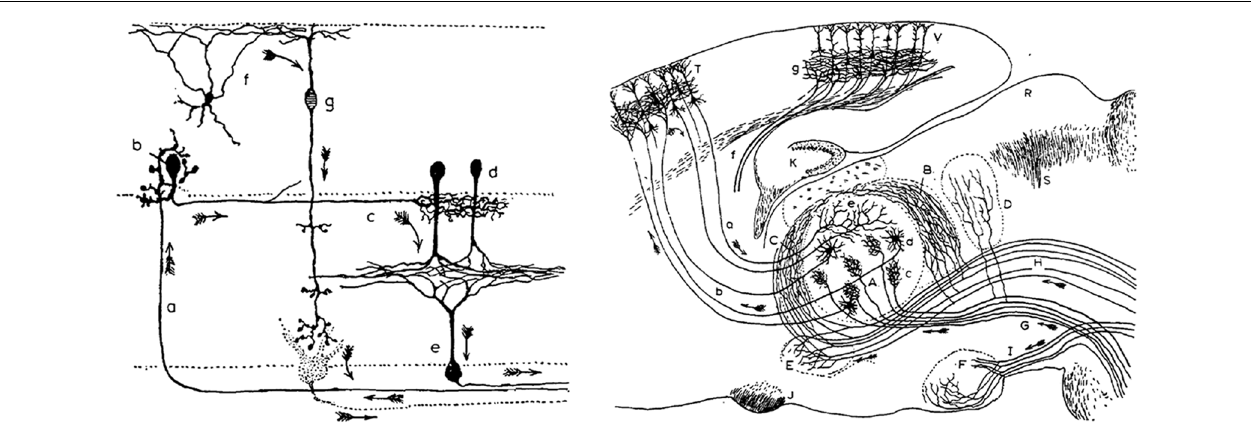
FIGURE 1 | Early descriptions of feedback pathways in subcortical and cortical structures. These drawings of neural circuits by Santiago Ramón y Cajal are among the first depictions of feedback pathways. (Left) Ramón y Cajal’s drawing of retinal circuitry. Arrows in the downward direction (arrows “g” and “e”) reflect feedforward or centripetal pathways from the photoreceptors towards higher-order brain structures for the transmission of visual stimuli. Ramón y Cajal additionally noted the presence of feedback or centrifugal fibers (arrow “a”) which originate in higher-order brain areas and target the retina. Thus, feedback occurs even at the earliest levels of sensory processing. (Right) Ramón y Cajal’s drawing of pathways of the somatosensory system. Demarcated are feedforward fibers from the brainstem to thalamus (arrow “G”) and from the thalamus to the cortex (arrow “b”). Also illustrated here are feedback fibers from cortex to thalamus (arrow “a”). While feedback fibers appear to be relatively sparse near the periphery, they are highly abundant in the thalamocortical system. In describing this anatomical organization during his Nobel prize speech in 1906, Ramón y Cajal speculated as to the function of feedback: “What is the role of the centrifugal fibres? Are they, as Duval thinks, conductors destined to produce in the sensory pathway articulations a very intimate contact which would be indispensable for the satisfactory propagation of the nervous impulse? Or rather do they transport some form of energy from the brain, the rapid accumulation of which in the sensory stations is necessary for the passage of ascending nerve currents? Unfortunately, at this stage of science, it is impossible to give satisfactory and categorical answers to these questions”. Now, over 100 years later, scientists continue to debate the functions of feedback fibers (panels and quote are reproduced with permission from © The Nobel